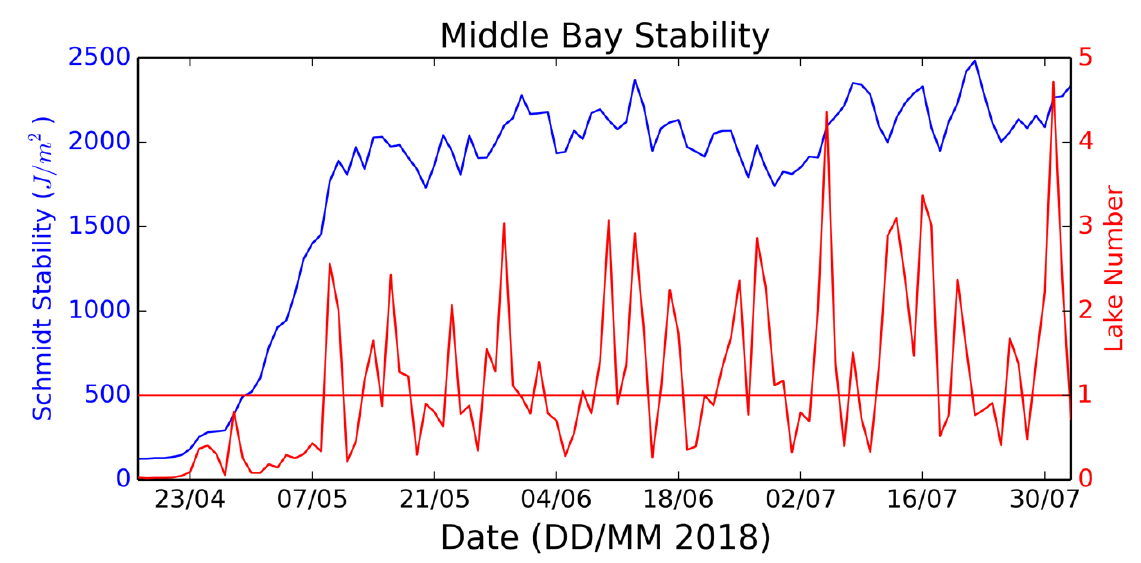
Figure 5. Schmidt Stability index and Lake Number for the area of middle bay estimated from FVCOM model results for 15 April to 2 August 2018. Table 3. Fluxes (m 3 /s) above and below the depth of the average density out of middle bay into the Glenora Gap for April to July, 2018. Surface outflows are positive to the east and bottom inflows are positive to the west across transect C in Figure 1. Monthly Middle Bay Fluxes Surface Outflow (m 3 /s) Bottom Inflow (m 3